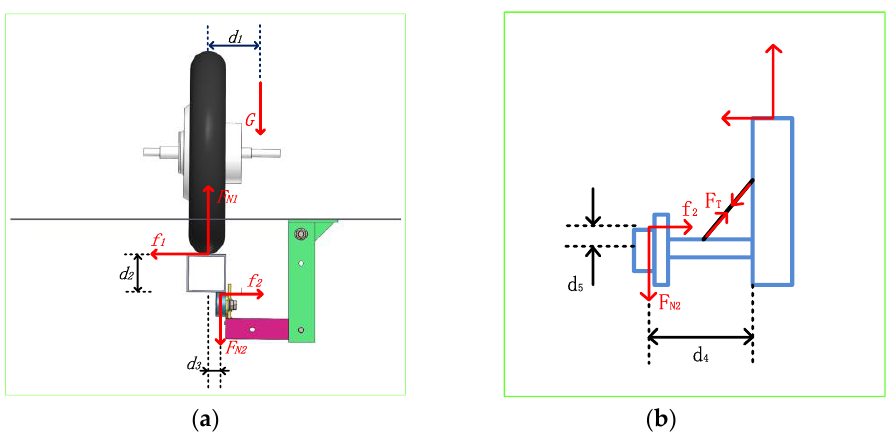
Figure 4. Force analysis . ( a ) Whole-car force analysis ( b ) Force analysis of the anti-tip device .